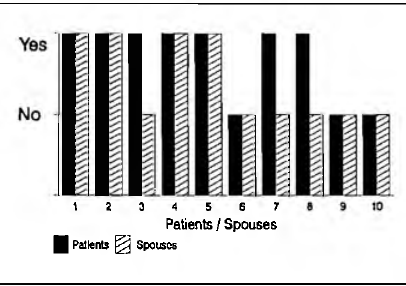
Figure 8. Knowledge of Exercise Programme Because group A were regular